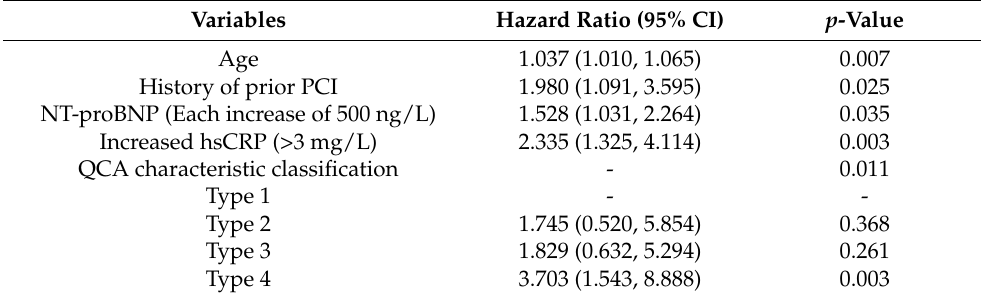
Table 3. The prediction model based on multivariable Cox regression.